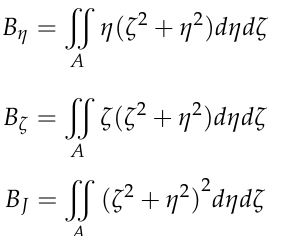
where u , v , and w are the spanwise, chordwise, and vertical deformations at any point of the blade (as shown in Figure 1), respectively; φ is the pre-twist angle at any point of the blade; ζ is the vertical position of any point on the blade cross-section; and η is the chordwise position of any point on the blade cross-section (as shown in Figure 2).